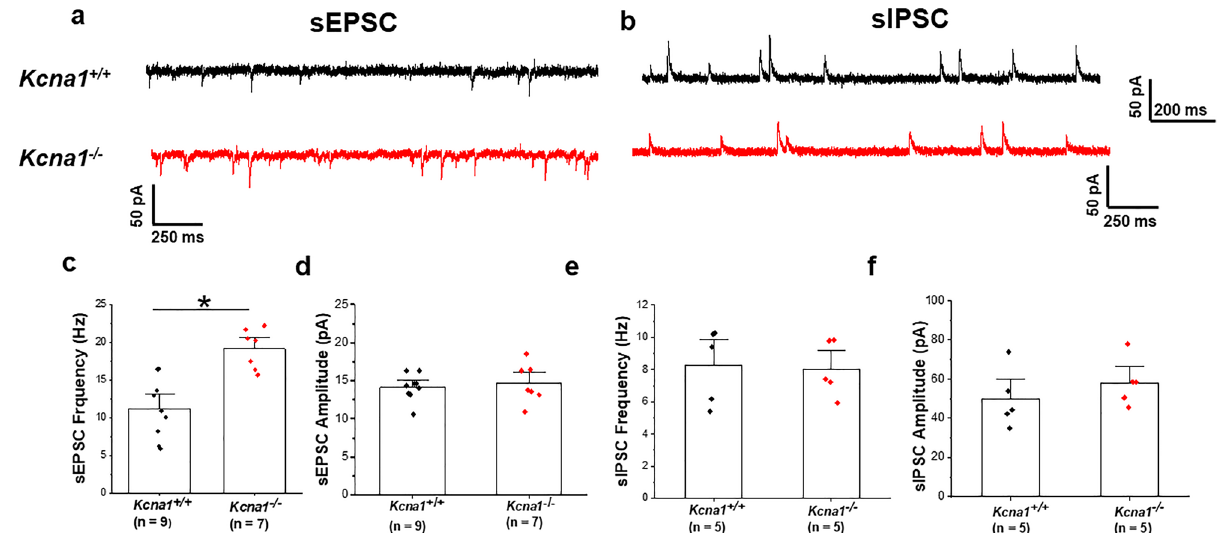
Figure 2. K v 1.1 deletion enhances spontaneous postsynaptic excitatory activity in BLA pyramidal neurons. Representative sEPSCs ( a ) and sIPSCs ( b ) were recorded from BLA pyramidal neurons in Kcna1 + / + (black traces) and Kcna1 −/− (red traces) mice. For sEPSCs, cells were held at a holding potential of − 70 mV and were recorded in presence of PTX (100 µM). For sIPSCs, cells were held at a holding potential of 0 mV and were recorded in presence of CNQX (20 µM) and D-AP5 (50 µM). ( c,d ) Mean data of sEPSCs frequency ( c ) and amplitude ( d ), showing an increase in sEPSCs frequency and no difference in amplitude . Kcna1 + / + , n = 9 cells from 5 mice; Kcna1 −/− , n = 7 cells from 5 mice. ( e,f ) Mean data of sIPSCs frequency ( e ) and amplitude ( f ) showing no significant changes in sIPSCs between Kcna1 −/− and Kcna1 + / + mice. Kcna1 + / + , n = 5 cells from 4 mice; Kcna1 −/− , n = 5 cells from 4 mice. *p < 0.05